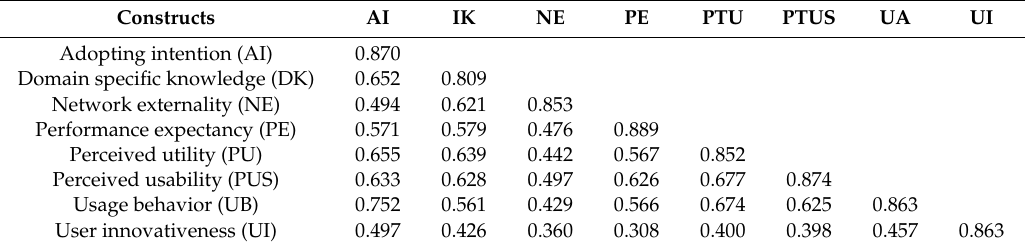
Table A8. The discriminant validity of this